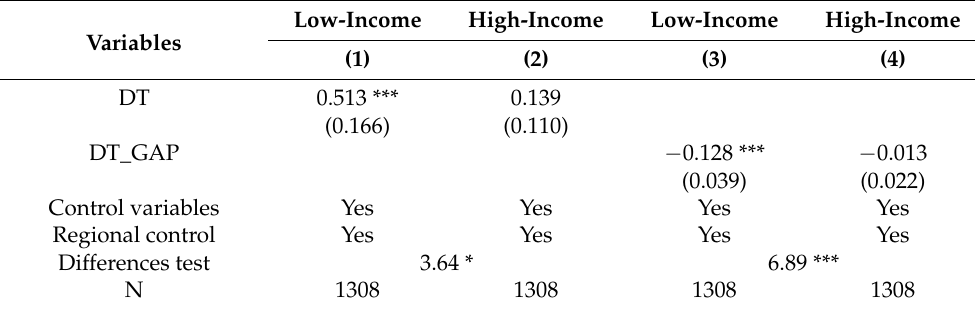
Table 10. Household income level heterogeneity: test results of the impact of DT & DT_GAP on LRB. Low-Income High-Income Variables